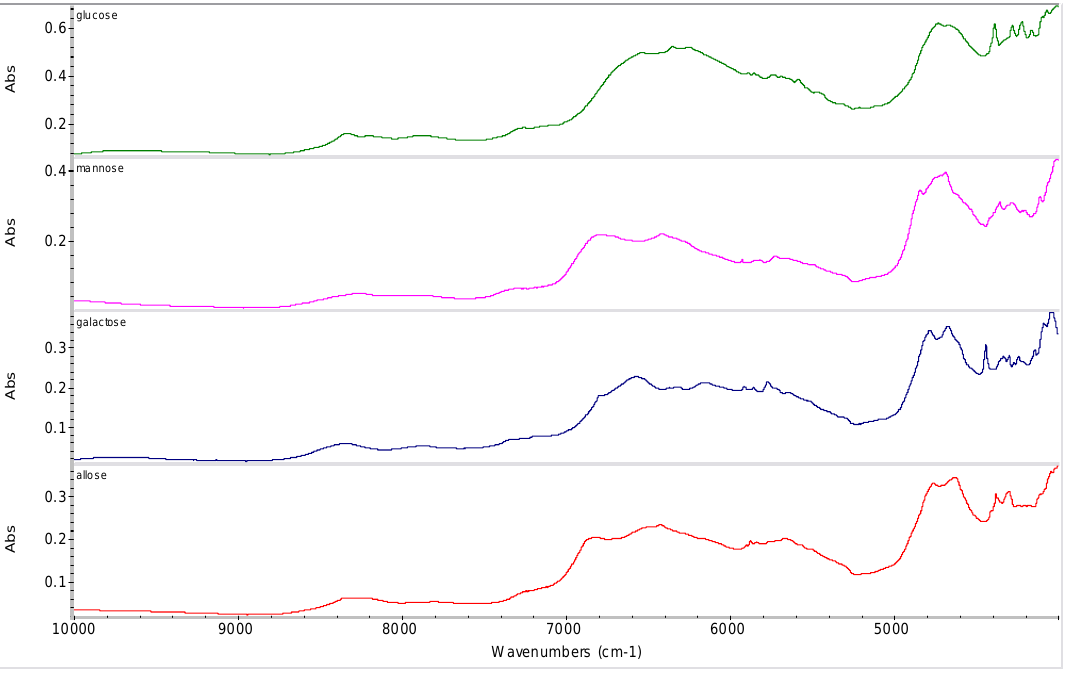
Figure 6. NIR spectra of discussed pyranoses.